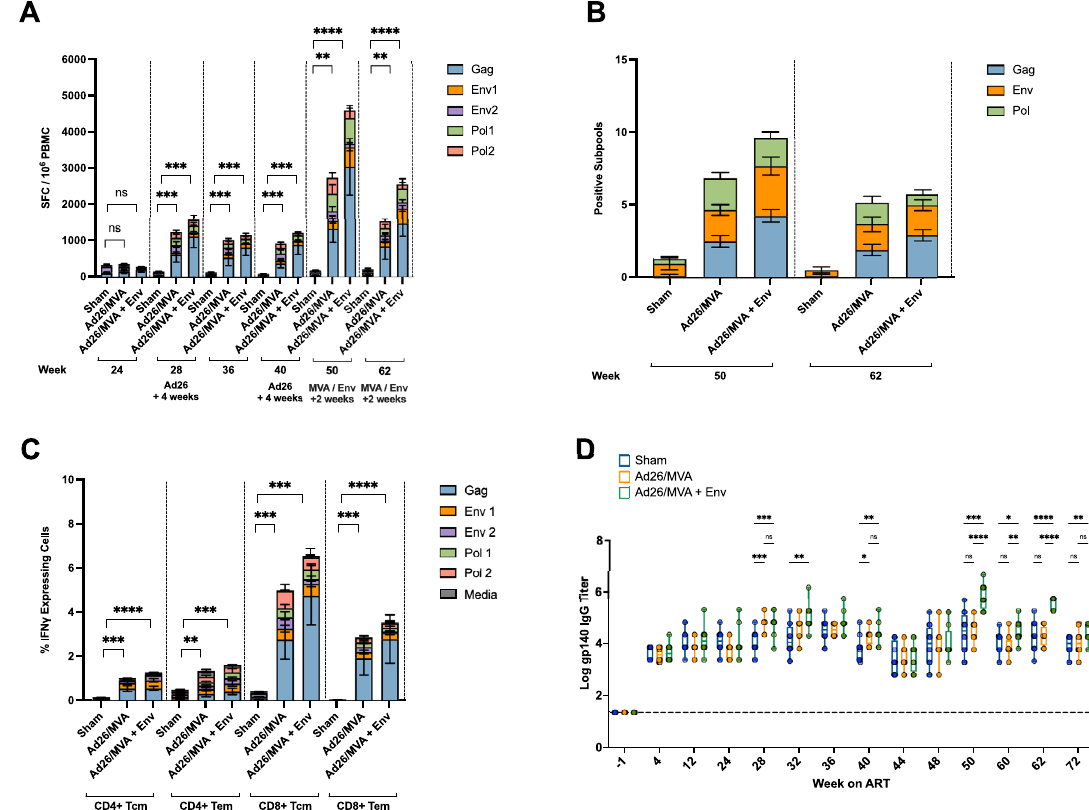
Fig. 2 Vaccine-elicited cellular and humoral immune responses following therapeutic vaccination and vesatolimod treatment. A SIV- speci fi c cellular immunity against Gag, Env, and Pol peptide subpools determined from IFN γ ELISpot assays performed on PBMCs sampled during Ad26/MVA and Ad26/MVA + Env therapeutic vaccination. Data shown as Spot Forming Cells (SFCs) per million cells. P values were derived from a Kruskal – Wallis test with Dunn ’ s correction for multiple comparisons of summed SFC counts for each treatment group. * < 0.05, ** < 0.01, *** < 0.001, **** < 0.0001. B Total immune breath of vaccine-induced SIV-speci fi c IFN γ production quanti fi ed as the summation of total Gag, Env, and Pol subpools. C Flow cytometric assessment of CD4 + and CD8 + intracellular IFN γ secretion at week 62